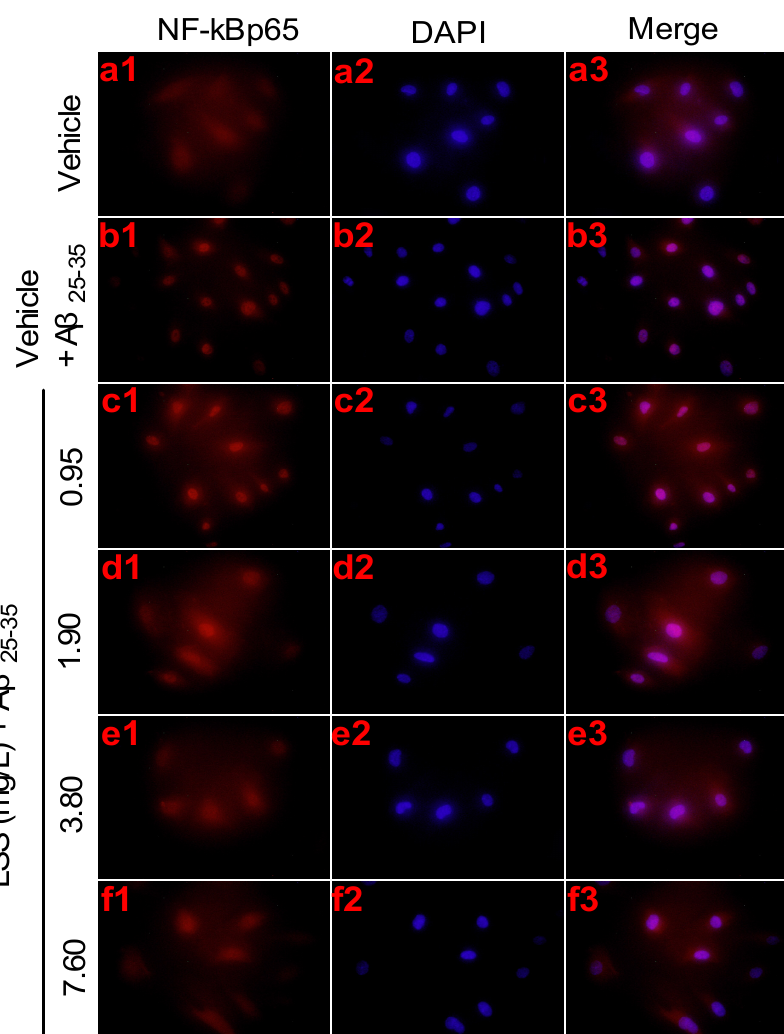
Figure 7. Effect of LSS on nuclear translocation of NF- κ Bp65 in PC12 cells treated with or without 20 µ mol/L A β 25-35 for 12 h (400 × ). ( a ) Control cells were treated with medium for 13 h without A β 25-35 ; ( b ) cells were treated with medium for 1 h and followed by 20 µ mol/L A β 25-35 for 12 h; ( c ) cells were treated with LSS 0.95 mg/L for 1 h and following by 20 µ mol/L A β 25-35 for 12 h; ( d ) cells were treated with LSS 1.90 mg/L for 1 h and followed by 20 µ mol/L A β 25-35 for 12 h; ( e ) cells were treated with LSS 3.80 mg/L for 1 h and followed by 20 µ mol/L A β 25-35 for 12 h; ( f ) cells were treated with LSS 7.60 mg/L for 1 h and followed by 20 µ mol/L A β 25-35 for 12 h. Numbers preceding letters represent the following: 1. red channel (NF- κ B); 2. blue channel (DAPI); and 3. combined figure of red and blue channels. The results are representative of at least three independent experiments run in